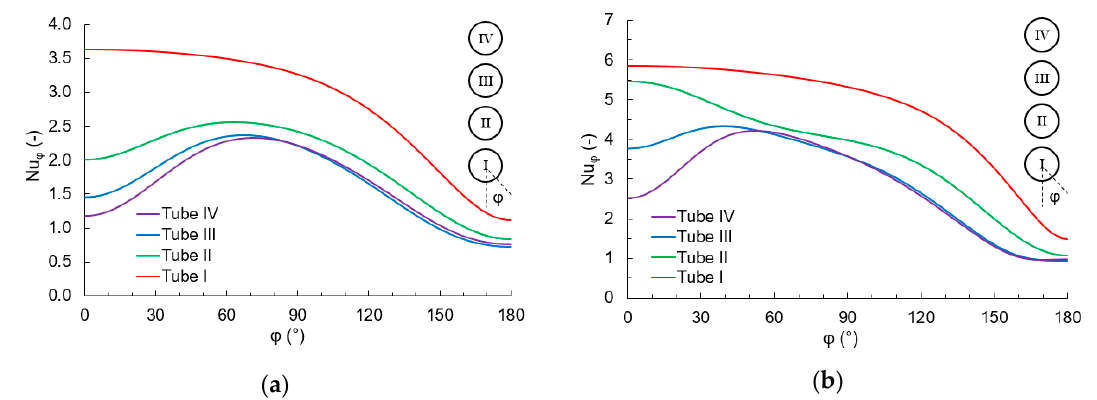
Figure 5. The course of the local Nusselt numbers Nu φ for the individual tubes in the tube array 4 × 1: ( a ) Ra = 10 3 ; ( b ) Ra = 10 4 .